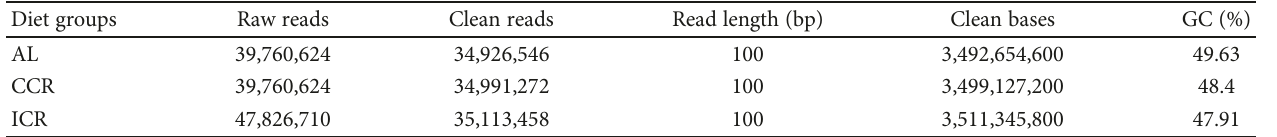
Table 2: The statistical results for the AL, CCR, and ICR diet groups ’ libraries.